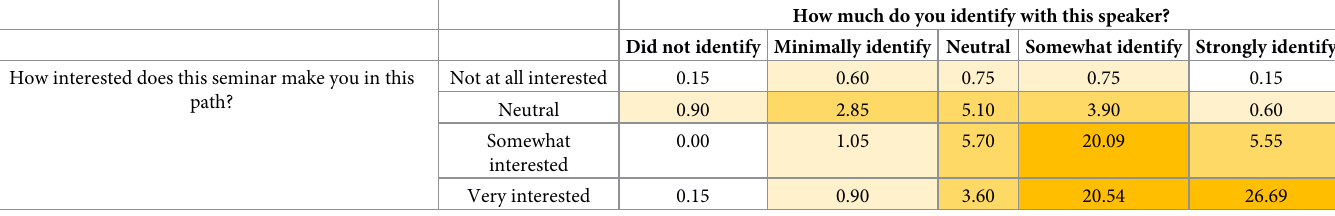
Table 2. There is a positive association between identifying with the speakers and interest in a career